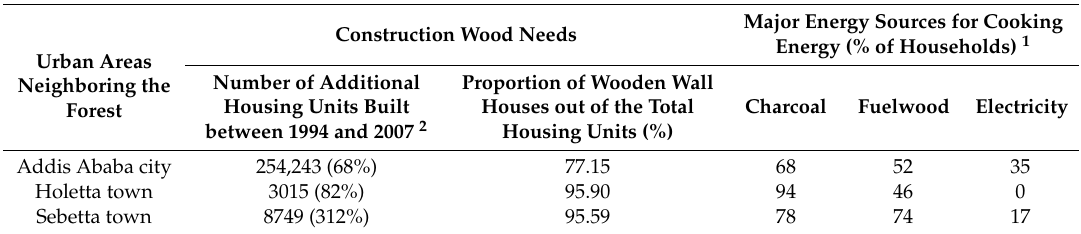
Table 1. Wood dependency in urban and peri-urban areas surrounding Menagesha Suba Forest